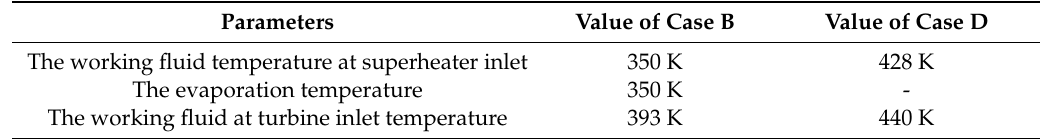
Table 3. Parameters used for case B and case